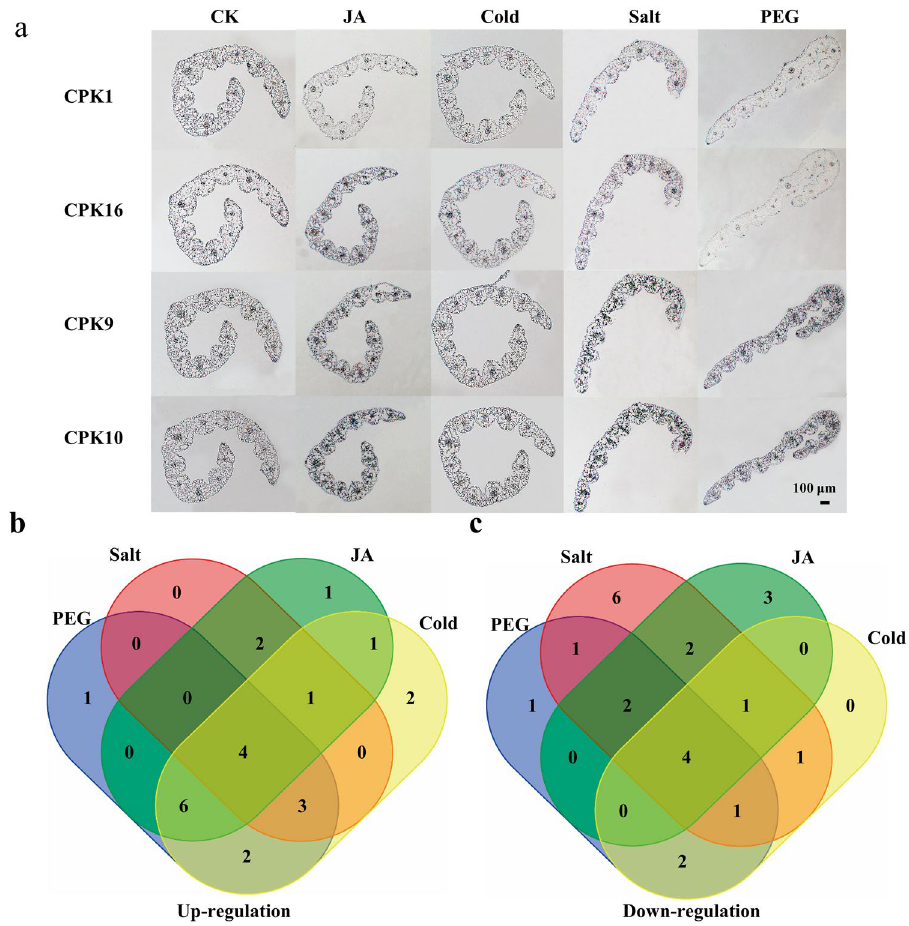
Figure 6. Localization of CDPK transcripts and cross-talk among different signalling pathways. ( a ) Longitudinal section of leaves probed with DIG-labeled antisense Hv CDPK1 , 16 , 9 and 10 transcripts. Bar = 100 μ m. Venn diagram showing the overlap of HvCDPK gene up-regulation ( b ) and down regulation ( c ) expression in response to MeJA, cold, salt and PEG